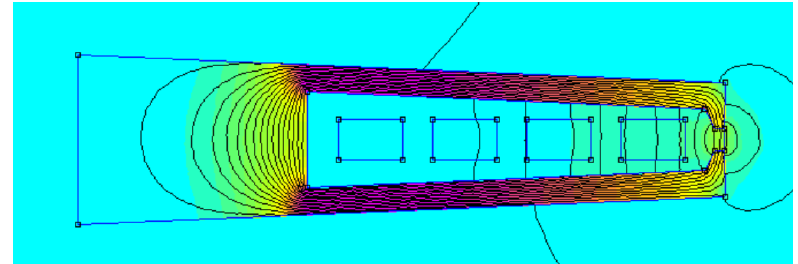
Figure 19. Polar shoes with the smallest